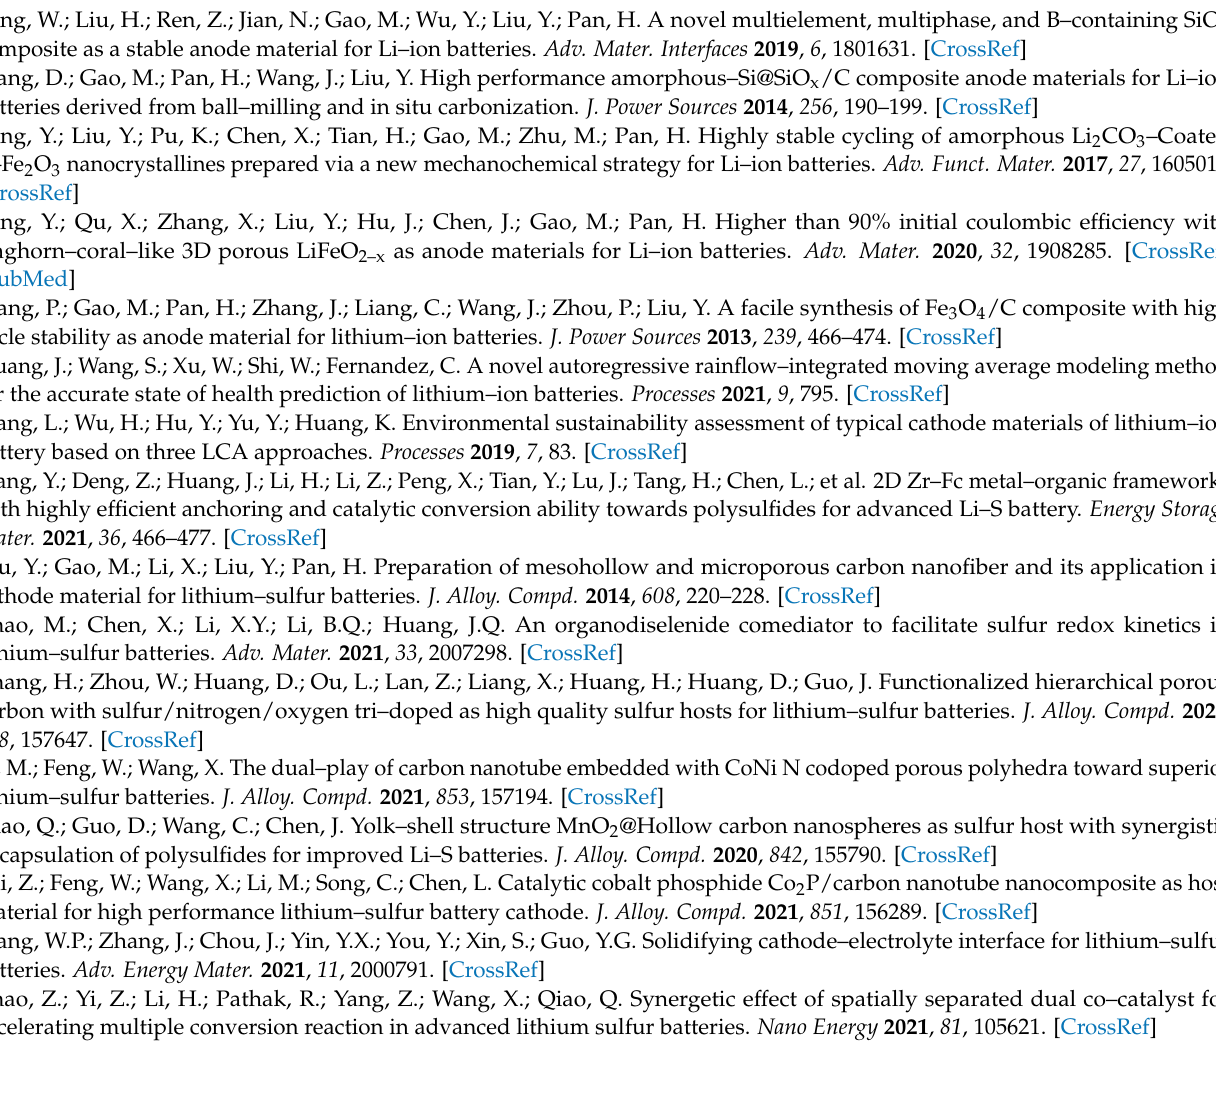
Figure S9: XPS survey spectra of NPCMs–Li 2 S after 500 cycles at 1.0 A g − 1 . Table S1: Electrochemical performance of various lithium sulfide − based